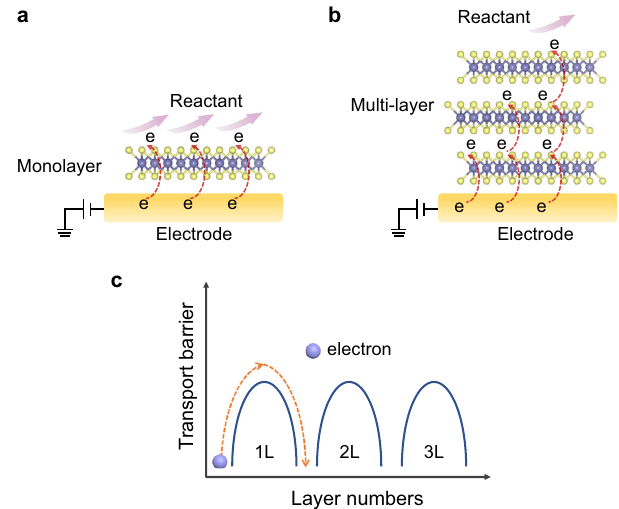
Fig. 5 | Layer-dependent electron transfer mechanism of MoS 2 . a , b Schematic illustration depicting electron transfer pathways in the vertical direction of monolayer and multilayer MoS 2 during the electrochemical reaction. c Electrons need to cross more transport barriers with increasing numbers of